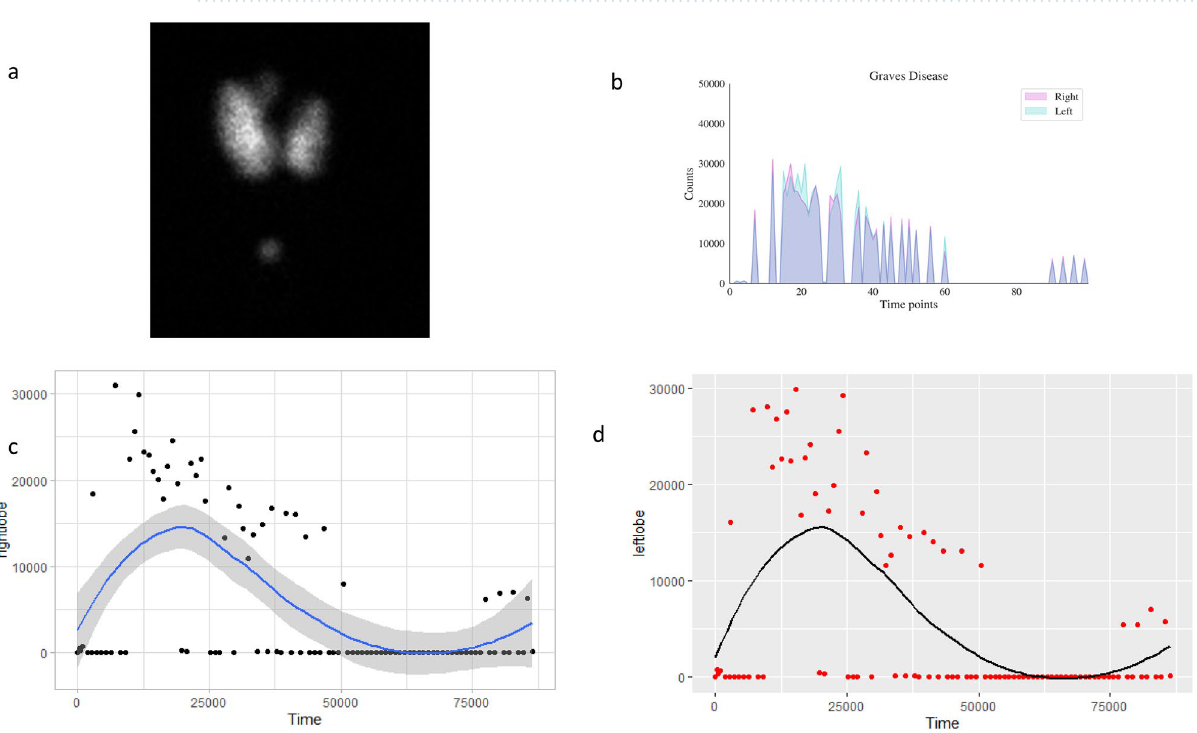
Figure 2. (Graves Patient 2) ( a ) 123 scan showing diffuse heterogenous uptake in both the lobes ( b ) superimposed uptake in the right and left side showing near similarity but with different pattern of uptake ( c ) Uptake (absolute counts) in the right lobe with counts and trend over time (in seconds) ( d ) Uptake (absolute counts) in the left lobe with counts and trend over time (in seconds) (loess curves are shown